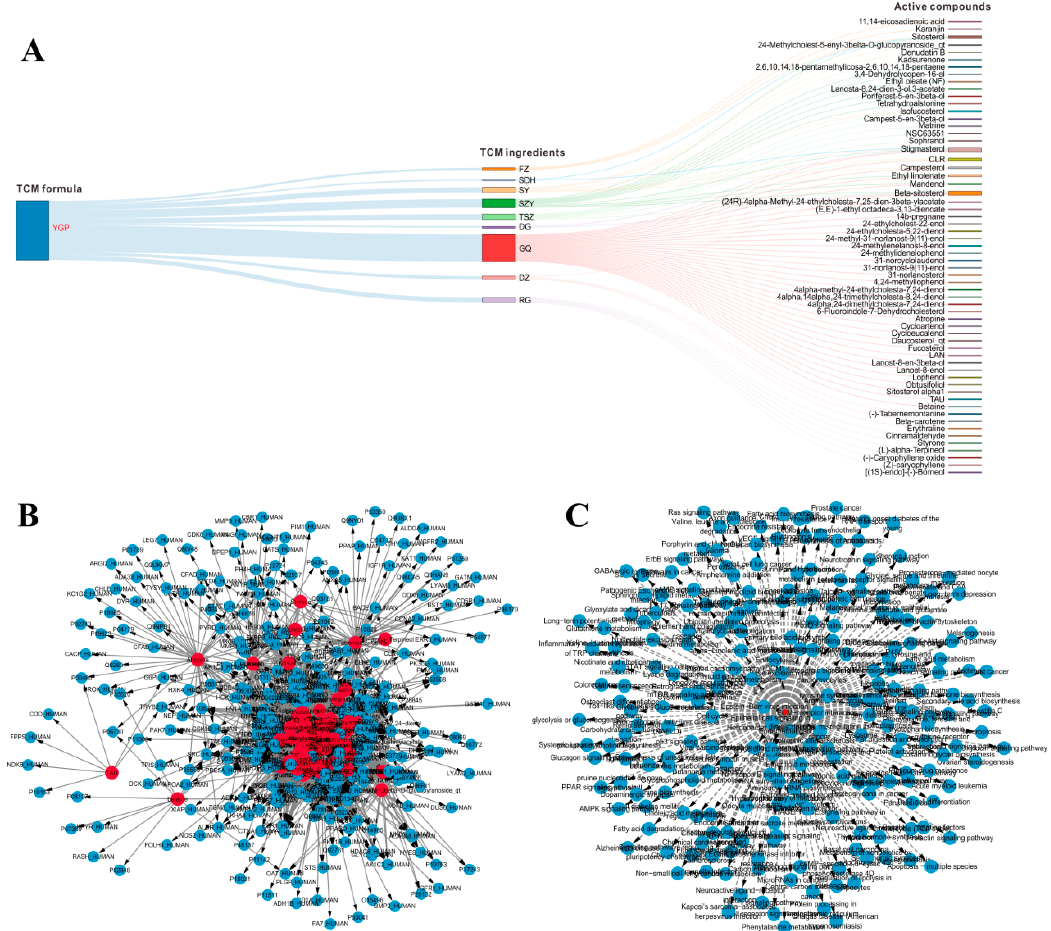
Figure 2. ( A ) The interaction graph among YGP, nine kinds of TCM ingredients, and 61 kinds of active compounds. ( B ) Sixty-one active compounds (red) and 3180 targets (cyan) network. ( C ) Sixty-one active compounds (red) and 234 pathways network (cyan).